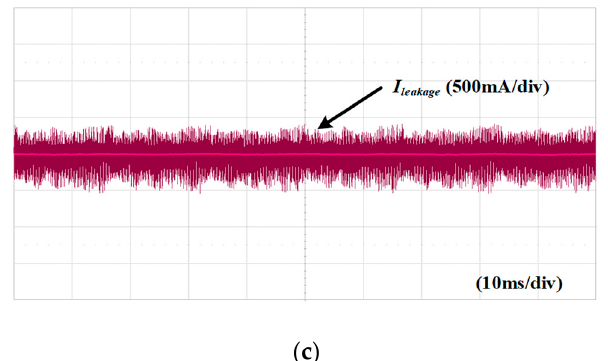
Figure 12. Experimental results of leakage current in time scale; ( a ) without output filter; ( b ) with dv/dt filter; and ( c ) with sine-wave filter.